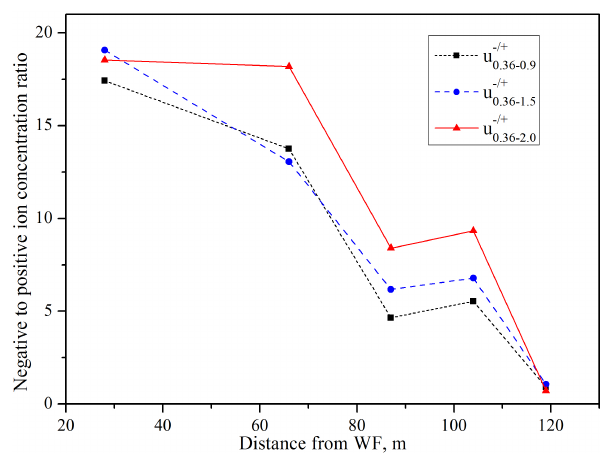
Fig. 10. Gartl WF with surroundings.